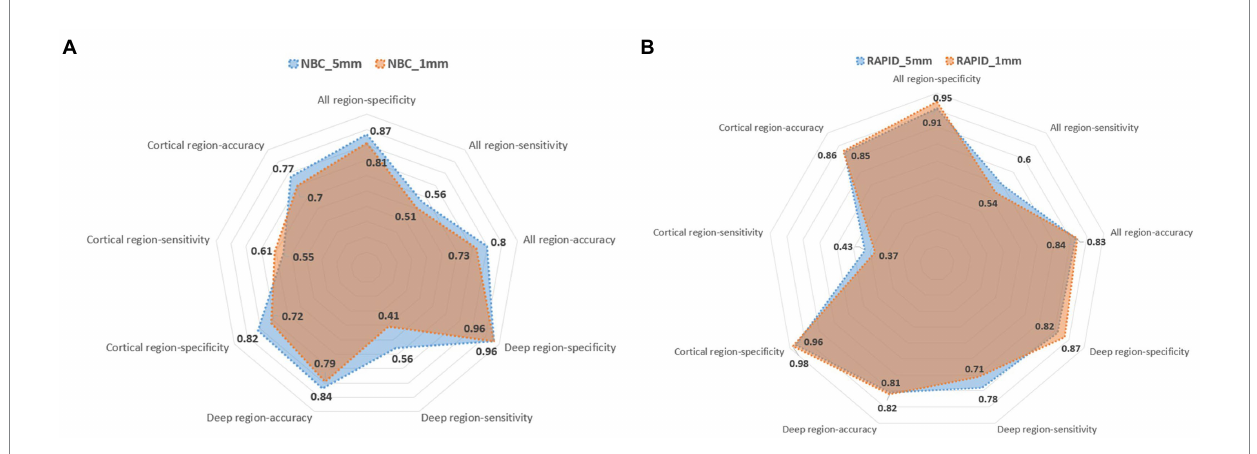
FIGURE 4 Visualization of the sensitivity, specificity and accuracy for automated ASPECTS calculated by NBC software (A) and RAPID software (B)